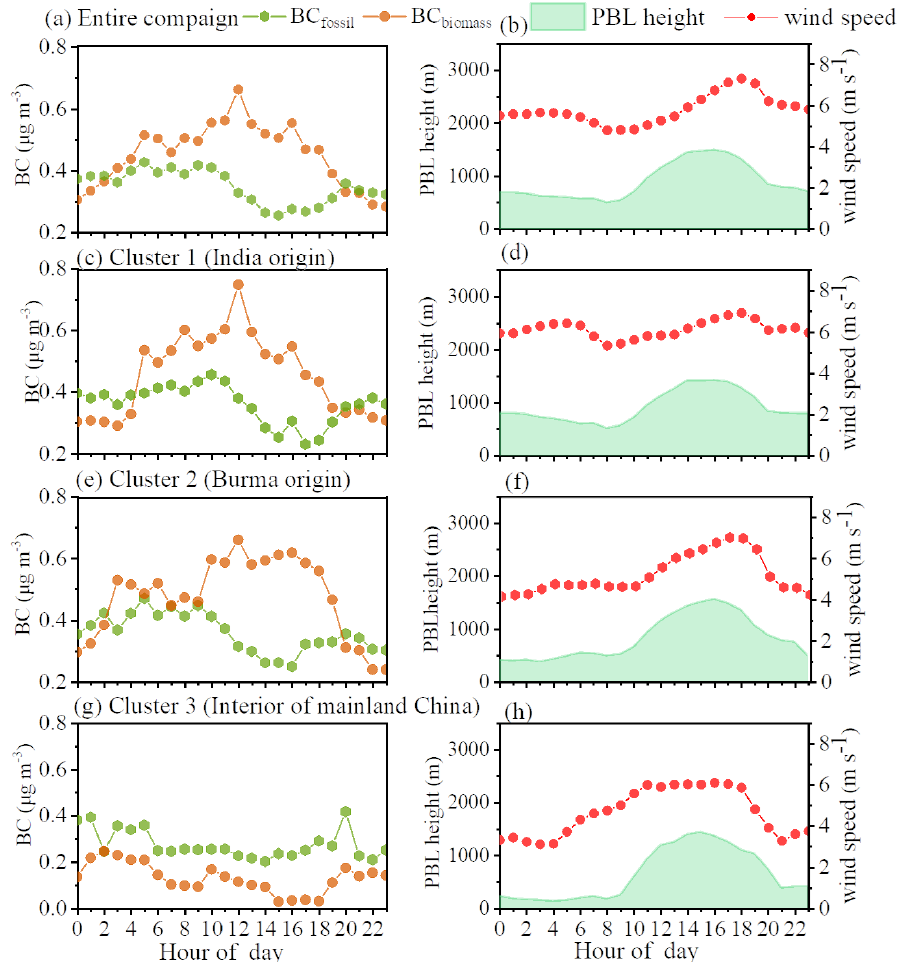
Figure 4. Left panels: diurnal variations in hourly averaged black carbon (BC) aerosol from biomass burning (BC biomass ) and fossil fuel sources (BC fossil ). Right panels: wind speeds and planetary boundary layer (PBL) heights during the entire campaign and for different air mass directions determined by air mass trajectory clusters